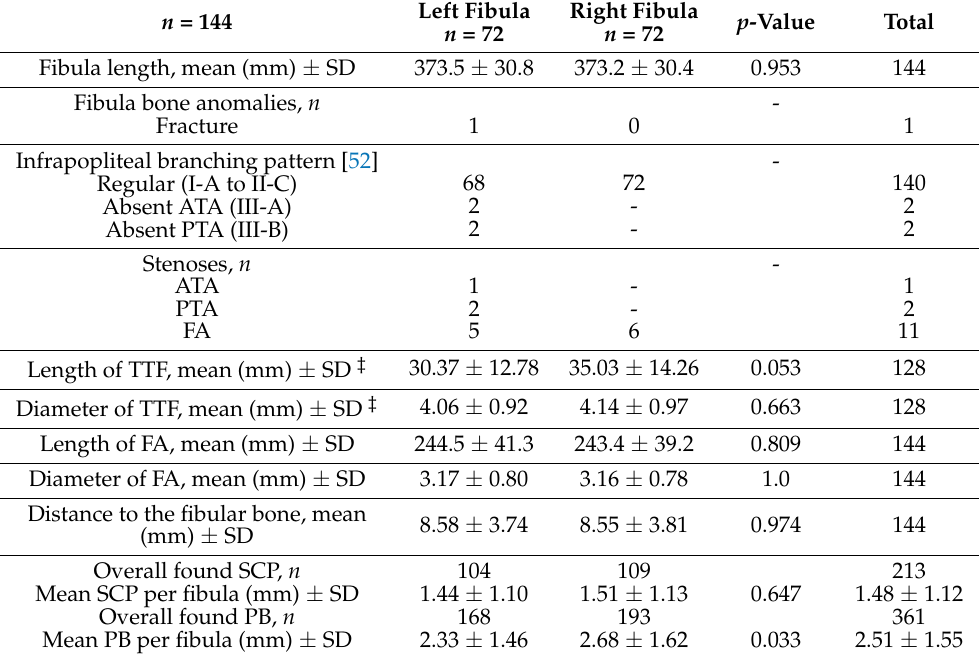
Table 2. CTA assessment for the study sample’s fibula bone and vascular system parameters (SD, standard deviation; ATA, anterior tibial artery; FA, fibular artery; PB, periosteal branch; PTA, posterior tibial artery; SCP, septo-cutaneous perforator; TTF, truncus tibiofibularis). Annotation: ‡ Length and diameter of TTF were only assessed for type I-A branching pattern.